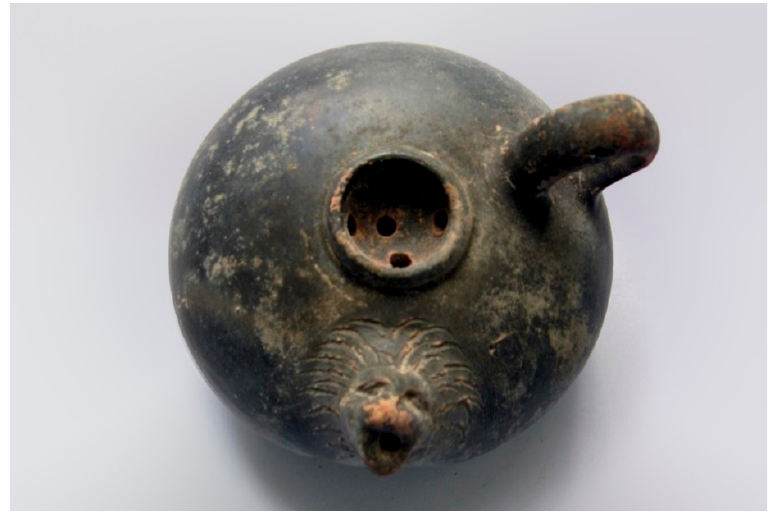
Figure 19. Lion-headed spout (MGW inv. no. 2326); black ceramic pouring vessel (guttus); ca. 4th–3rd century BCE .